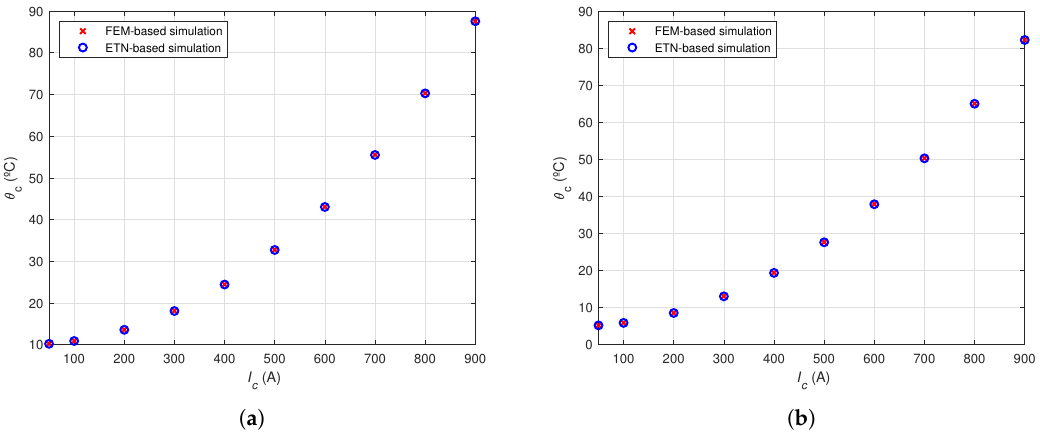
Figure 18. Estimation results for θ c in Cable 1H where: ( a ) θ amb = 10 ◦ C; ( b ) θ amb = 5 ◦